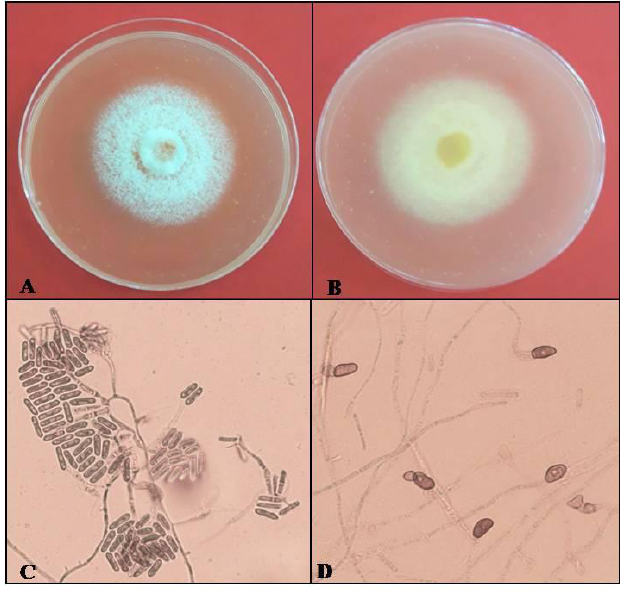
Figure 2. Colony growth of 3-day-old C. siamense in V8JA medium, obverse ( A ) and reverse ( B ); unicellular and hyaline conidia ( C ) and brown to brownish appressoria ( D ). Scale bars = 20 µ m.